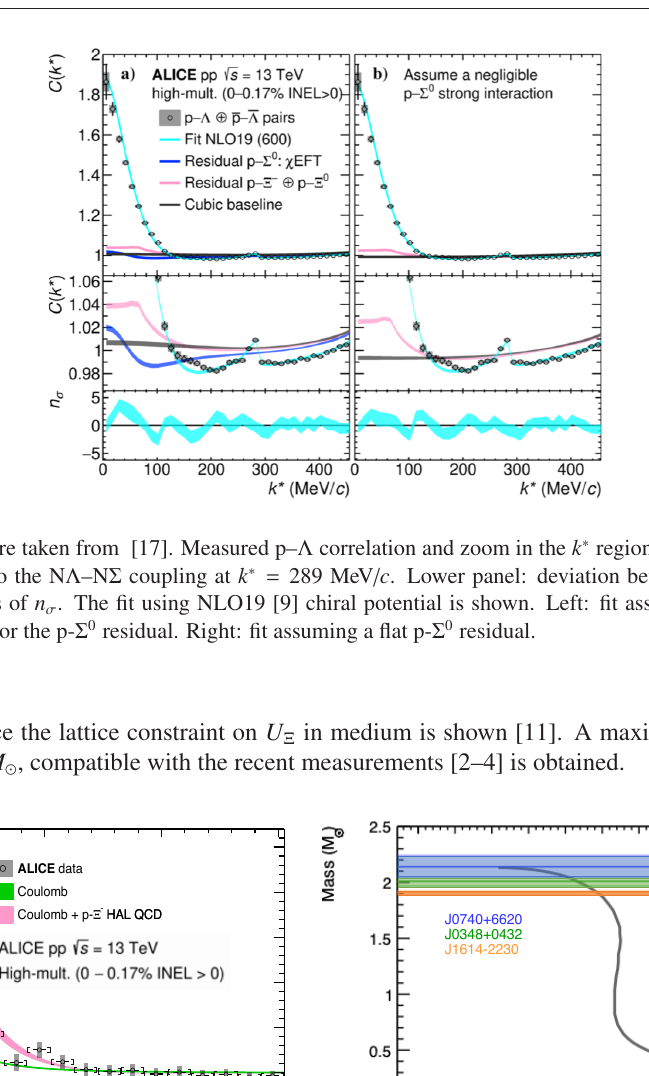
Figure 4. Left: Figure taken from [13]. Measured p– Ξ − correlation function in high multiplicity pp collisions at √ s = 13 TeV by ALICE Collaboration. The fits assuming Coulomb-only (green) and Coulomb + strong HAL QCD potentials (pink) are shown [19]. Right: mass-radius relation obtained by assuming the predicted HAL QCD Ξ interaction in medium [21]. Recent astrophysical measurements of massive NS are shown in blue, green and orange